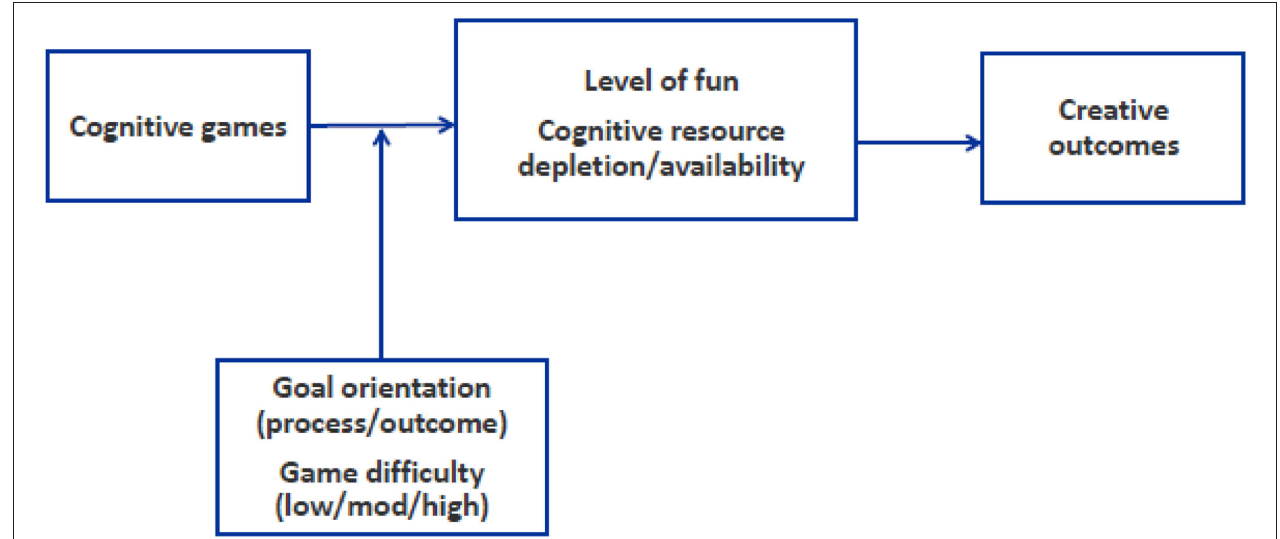
FIGURE 1 | Overview of the theoretical